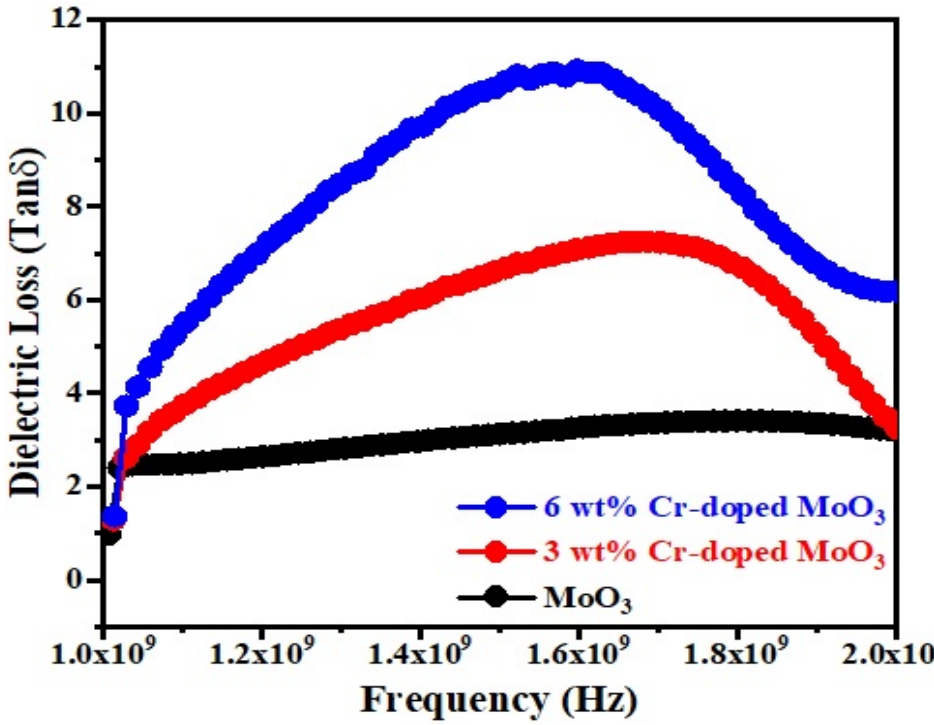
Figure 8. Dielectric loss as a function of frequency of un-doped and Cr-doped MoO 3.